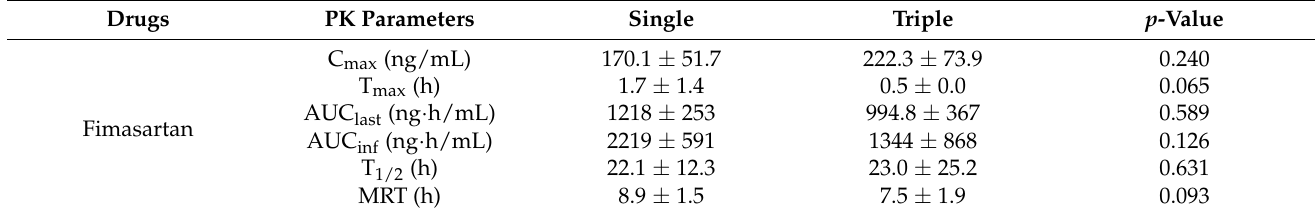
Figure 3. Plasma concentration–time profile of ( A ) fimasartan, ( B ) fimasartan-amide, ( C ) amlodipine, and ( D ) hydrochlorothiazide in rats that were orally administered a mixture of fimasartan (3 mg/kg), amlodipine (5 mg/kg), and hydrochlorothiazide (5 mg/kg) (triple, ● ) or a single component with the same dose (single, ○ ). Data represent the mean ± standard deviation ( n = 5). Table 5. Pharmacokinetic parameters of fimasartan, fimasartan-amide, amlodipine, and hydrochlorothiazide in rats that were orally administered monotherapy or a combination of fimasartan (3 mg/kg), amlodipine (5 mg/kg), and hydrochlorothiazide (5 mg/kg).